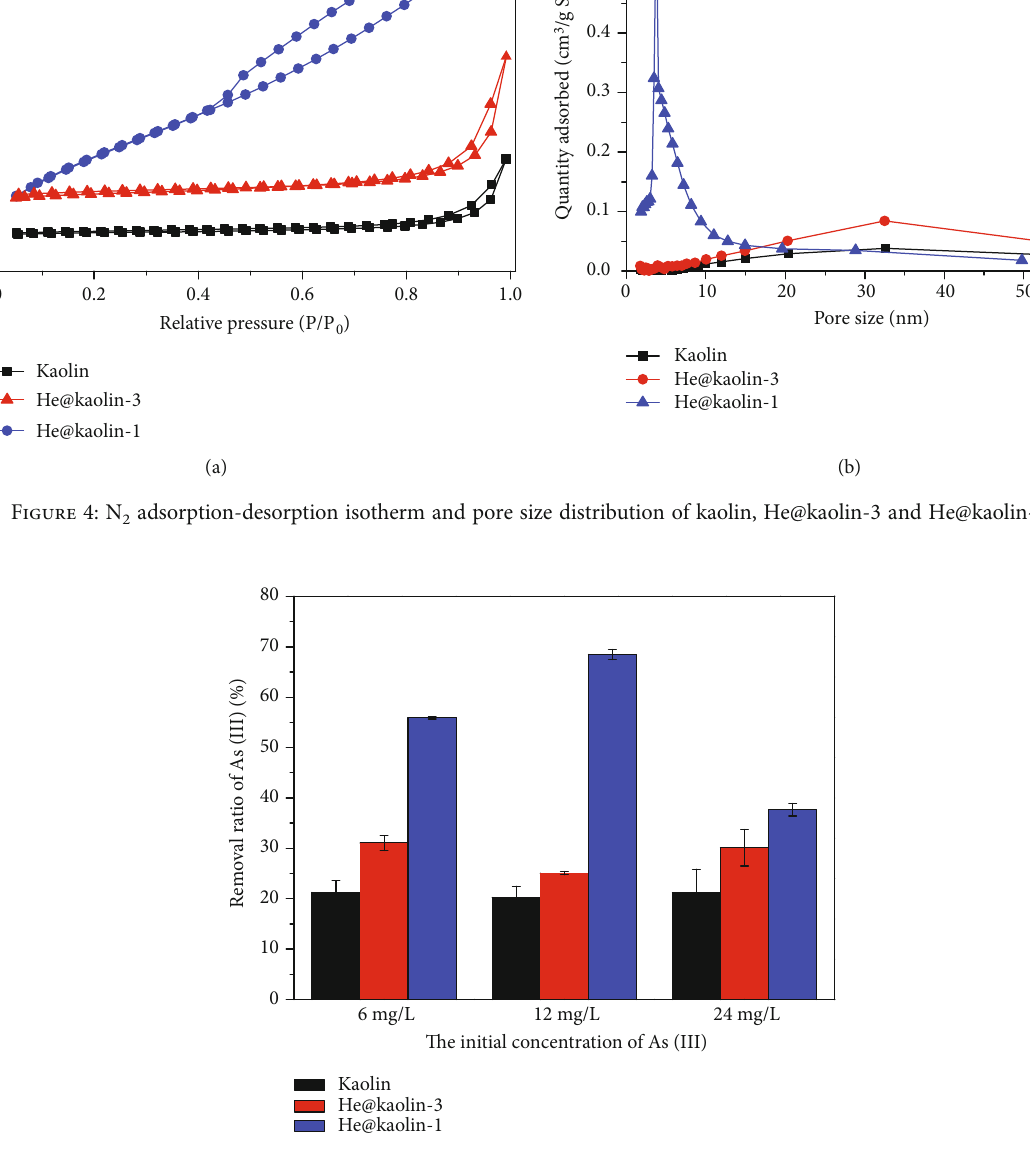
Figure 5: Removal ratio of As(III) by kaolin, He@kaolin-1, and He@kaolin-3 at di ff erent initial As (III) concentrations (6, 12, and 24mg/L). Table 1: Removal amount of As(III) by kaolin, He@ kaolin-1, and He@ kaolin-3 at di ff erent initial As (III) concentrations (6, 12,